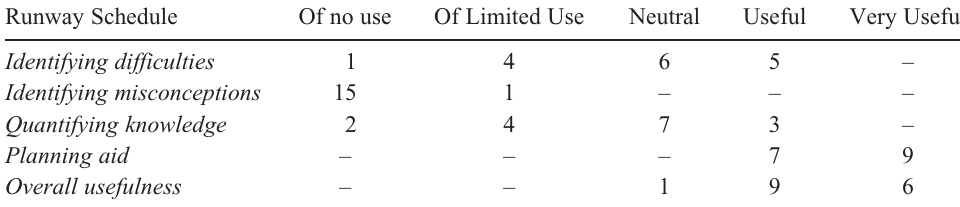
Table 5. Users’ perceptions of utility of runway schedule. Runway